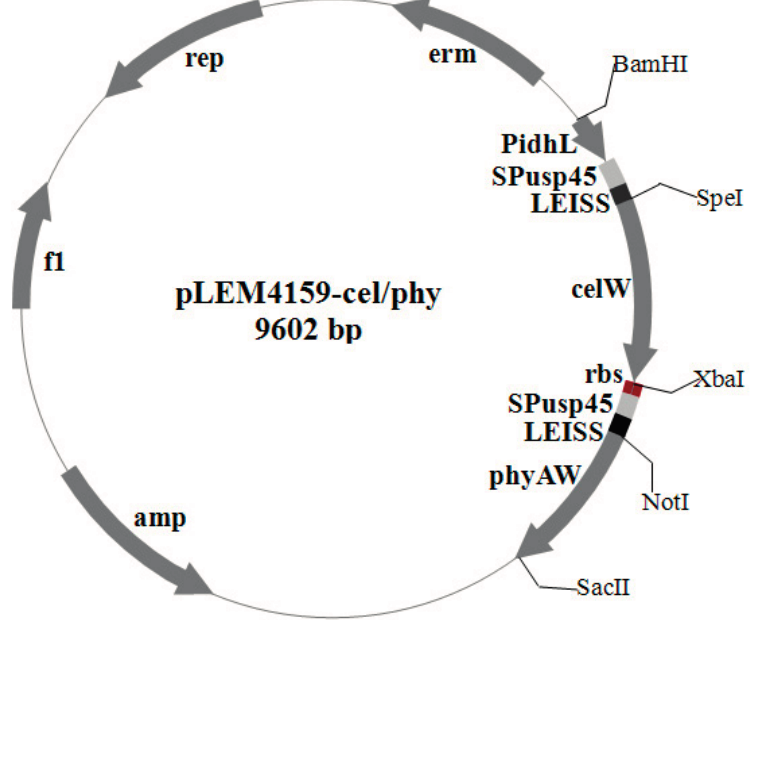
Figure 1. Lactobacillus expression plasmid harboring B. subtilis WL001 endoglucanase gene celW , A. fumigatus WL002 phytase gene mature peptide phyWM , P usp45 gene signal peptide SP , enhancer LEISS and ribosome binding site rbs usp45